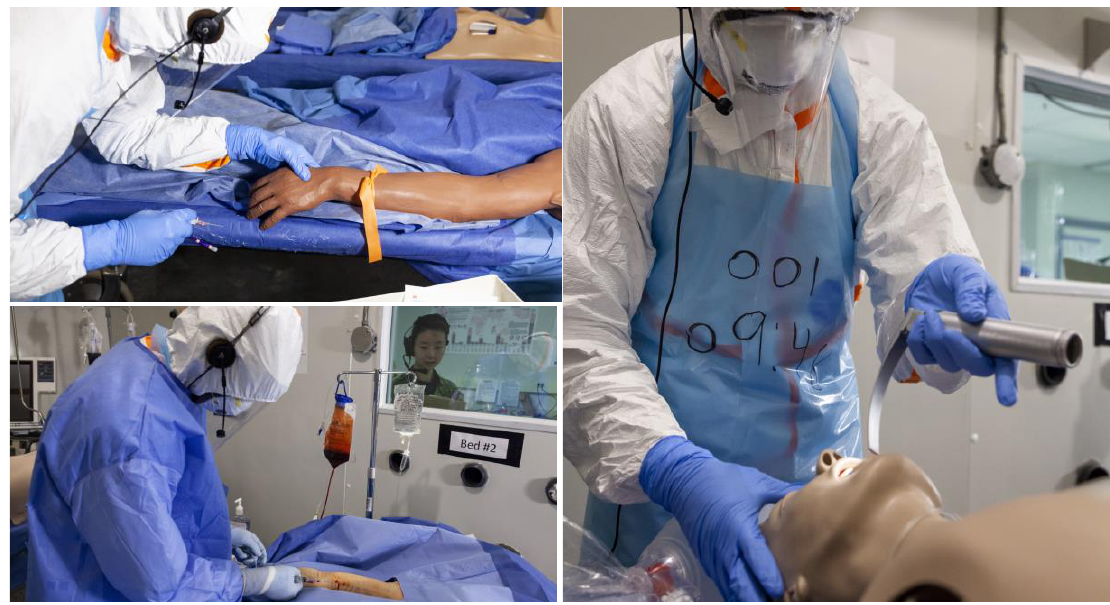
Figure 2. Participant in personal protective equipment (PPE) inserting peripheral intravenous catheter (top left) and midline catheter (bottom left) and performing endotracheal intubation (right).